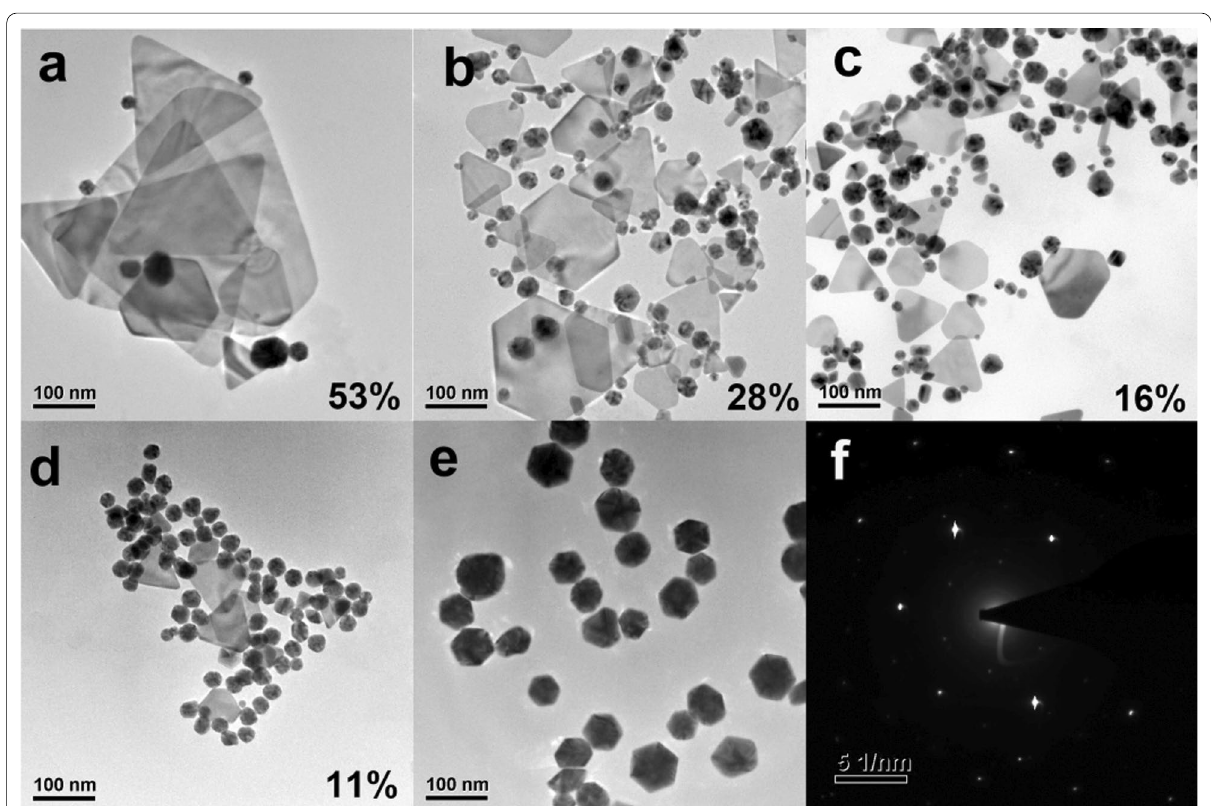
Fig. 2 TEM characterizations of GNPs prepared with the feeding rate of 0.5, 1.0, 1.5, 2.0 and 2.5 mL nanoplates ( f